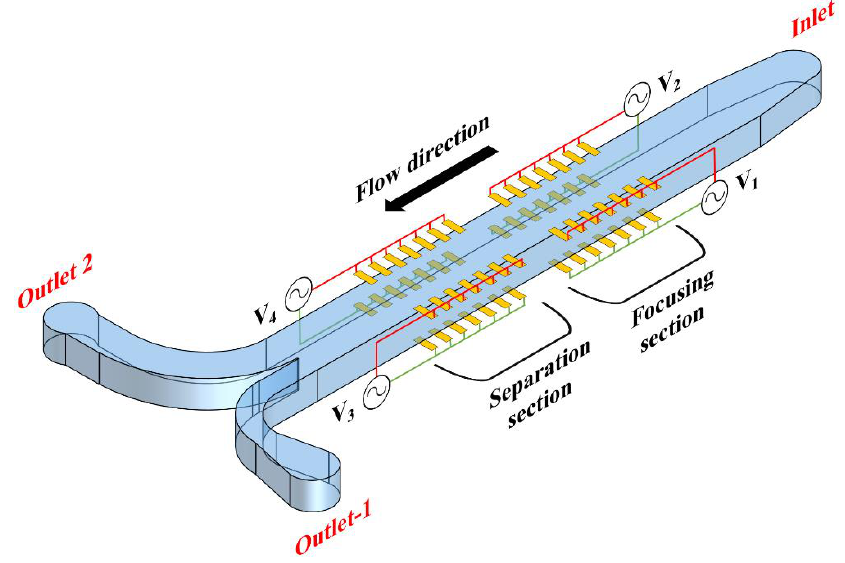
Figure 2. Schematic of the proposed microfluidic device (perspective view).